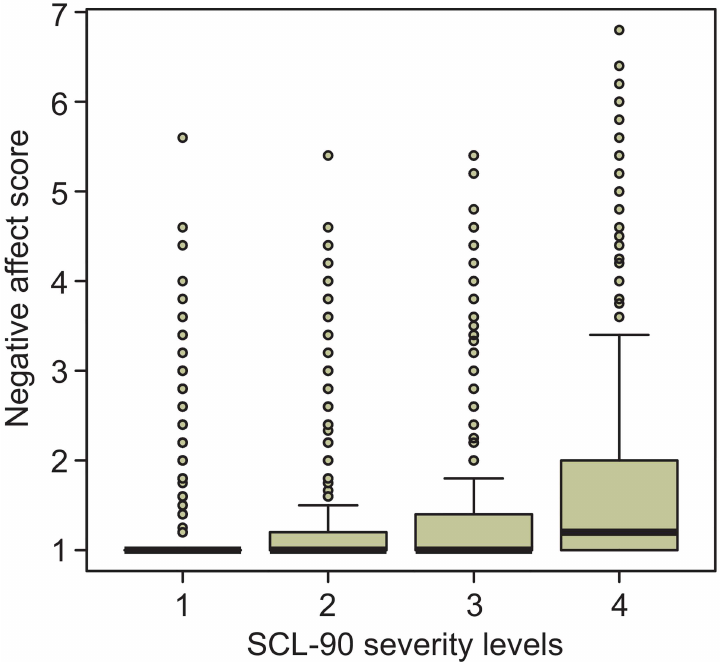
Fig 4. Boxplots of the distributions of the negative affect score across severity subgroups. The “boxes” indicate the interquartileranges (IQR). The median observations are indicatedby thick lines in the boxes. The “whiskers” extend to the highest (and lowest) observations not further away from the box than 1.5 times the IQR. Outliers are representedby small